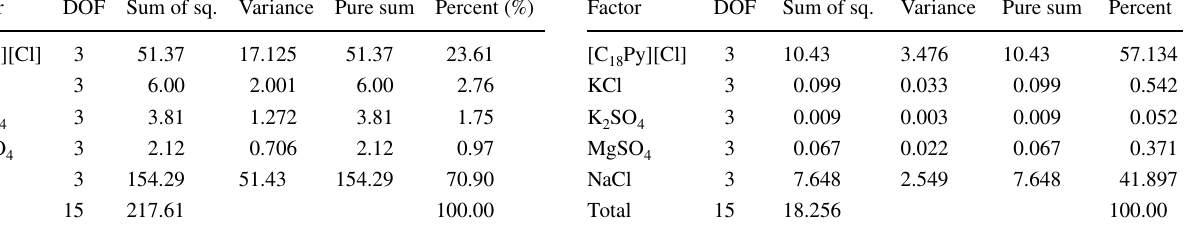
Fig. 3 Dynamic IFT values of the sixteenth tests during 1800 s; a [C concentration levels, and b [C 18 Py][Cl] with the presence of KCl, K 2 SO 4 , MgSO 4 and NaCl at different concentration levels Table 6 Analysis of variance (ANOVA) under the effect [C IL Factor DOF Sum of sq. Variance Pure sum Percent (%)